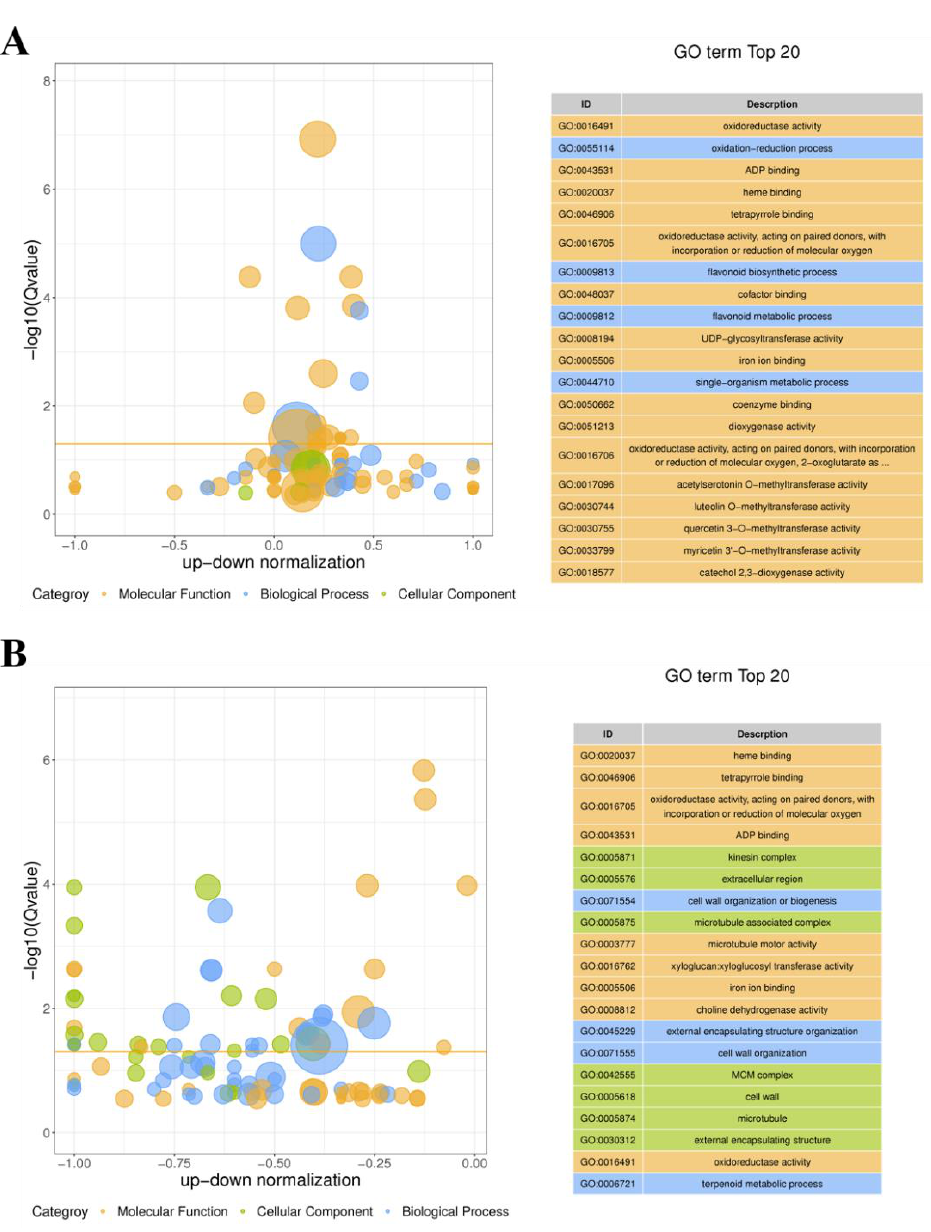
Figure 4. GO Function Enrichment Analysis of Differentially Expressed Genes (DEGs). ( A , B ), two charts show the top 20 GO terms of DEGs between control (CK-Y) and treated leaves (C-Y) ( A ) and between control (CK-J) and treated (C-J) stems ( B ). In the GO enrichment difference bubble charts, the ordinate is -log10 (Qvalue) and the abscissa is z-score value. The two charts show the proportion of the difference between the number of differentially upregulated and downregulated genes in the total DEGs. The yellow line represents the threshold of Q value = 0.05. The right tables include the GO term list of the top 20 Q values. Different colors represent different Ontologies, which are separated by their class. GO, Gene Ontology